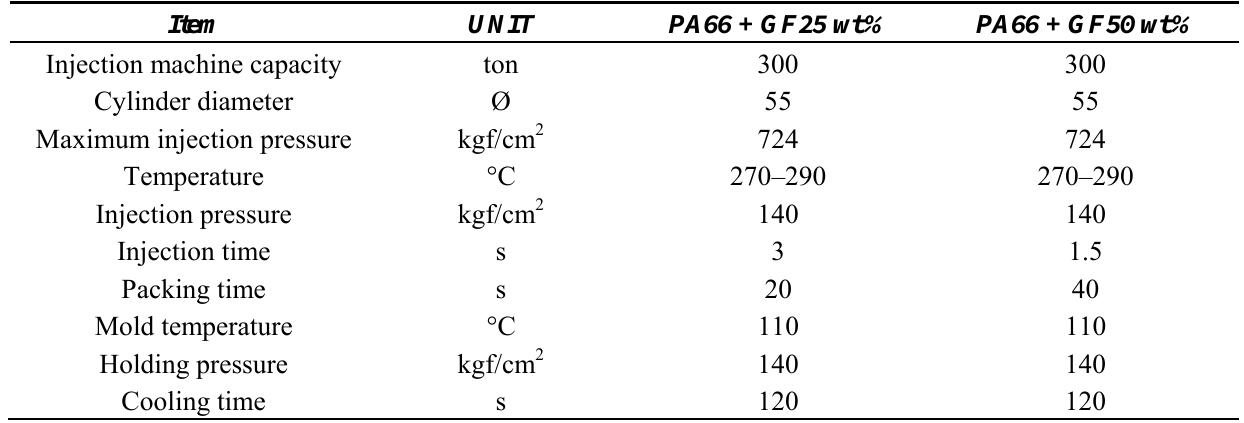
Table 7. Detailed injection molding conditions for plastic worm